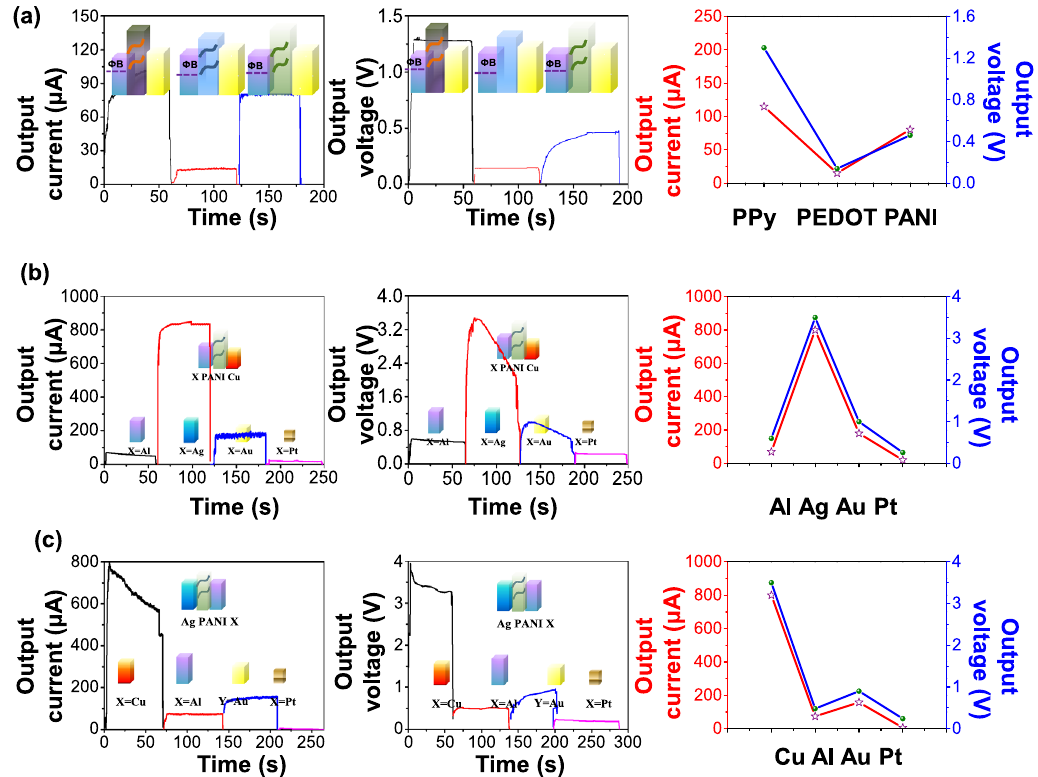
Figure 4. ( a ) Influence of different conductive polymers on direct-current generator. Output currents (left panel) and output voltages (middle panel) of direct-current generators: Au/PPy/Al, Au/PEDOT/Al, Au/PANI/ Au (4% compressive deformation), respectively. Right panel: The relationship of the output currents/voltages with varied contacted metals. ( b ) Influence of different Schottky-contacted metals (fixed the Ohmic-contacted metals) on PANI-based direct-current generator. Output currents (left panel) and output voltages (middle panel) of direct-current generators: Cu/PANI/Al, Cu/PANI/Ag, Au/PANI/Cu, Pt/PANI/Cu (4% compressive deformation), respectively. Right panel: the relationship of the output currents/voltages with varied contacted metals. ( c ) Influence of different contacted metals metals (fixed one Schottky-contacted metals) on PANI- based direct-current generator. Output currents (left panel) output voltages (middle panel) of direct-current generators: Ag/PANI/Cu, Ag/PANI/Al, Ag/PANI/Au, Ag/PANI/Pt (4% compressive deformation), respectively. Right panel: The relationship of the output currents/voltages with varied contacted